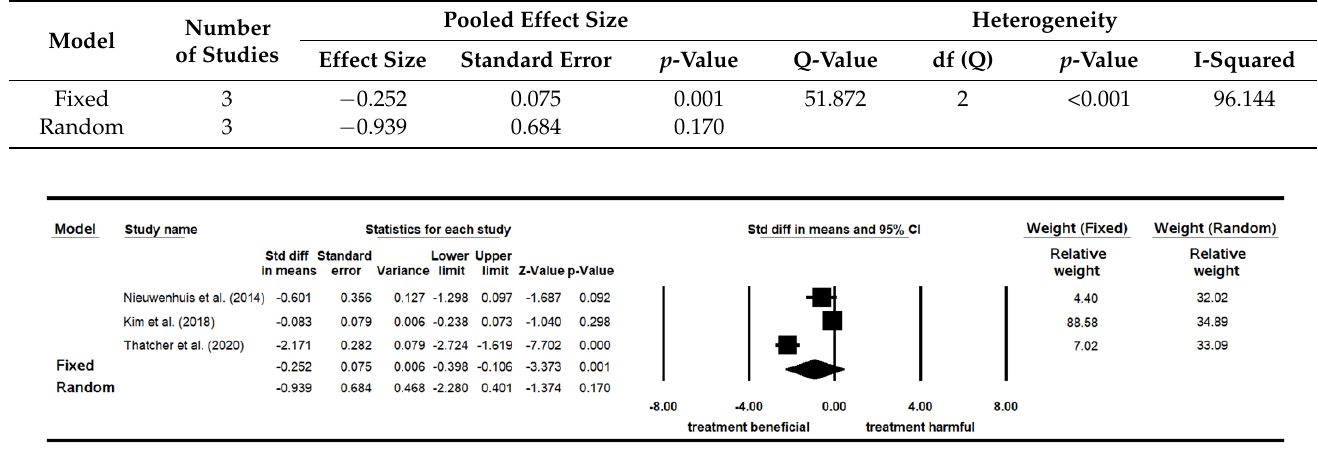
Figure 7. Forest plot of studies on the influence of indoor plants on response time [58,77,94].